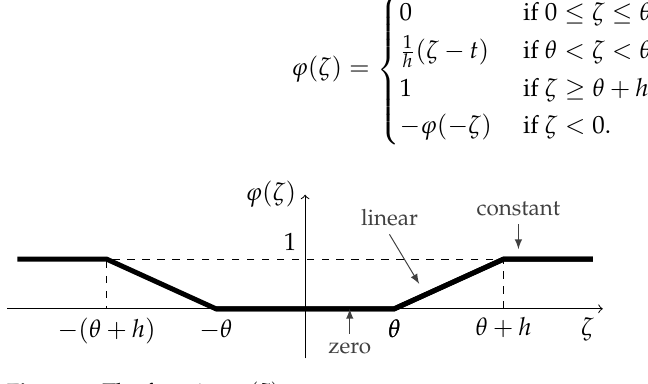
Figure 1. The function ϕ ( ζ )